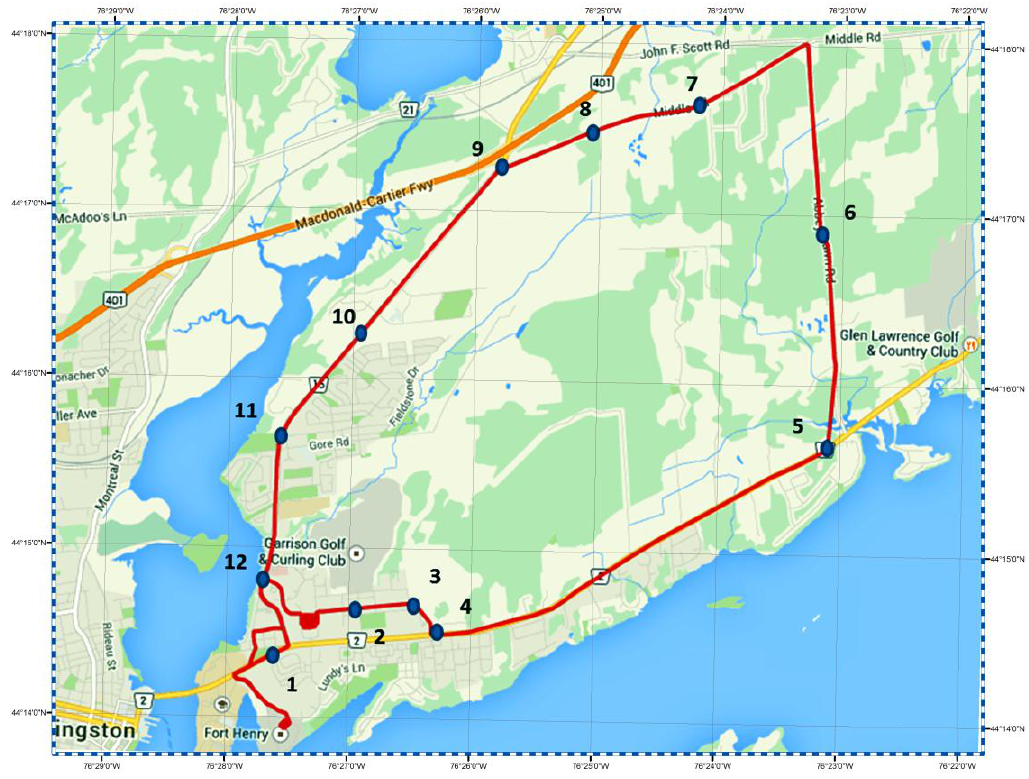
Figure 2. Vehicle test trajectory and simulated complete GPS outages.